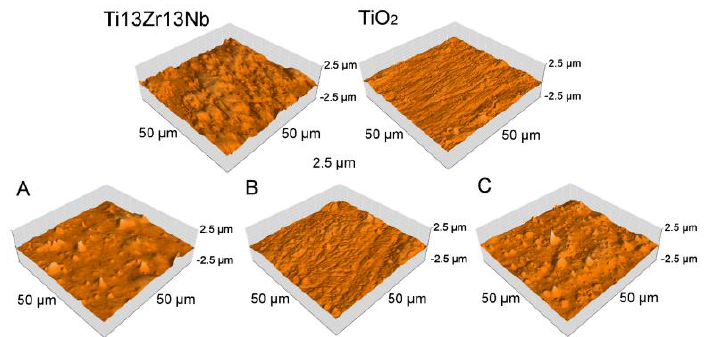
Figure 3. Atomic force microscopy (AFM) topography of the Ti13Zr13Nb substrate, the substrate with the TiO 2 nanotubular layer, Specimens A, B, and C. Table 3. Roughness parameters of the reference specimen, TiO 2 layer, and chitosan composite coatings.